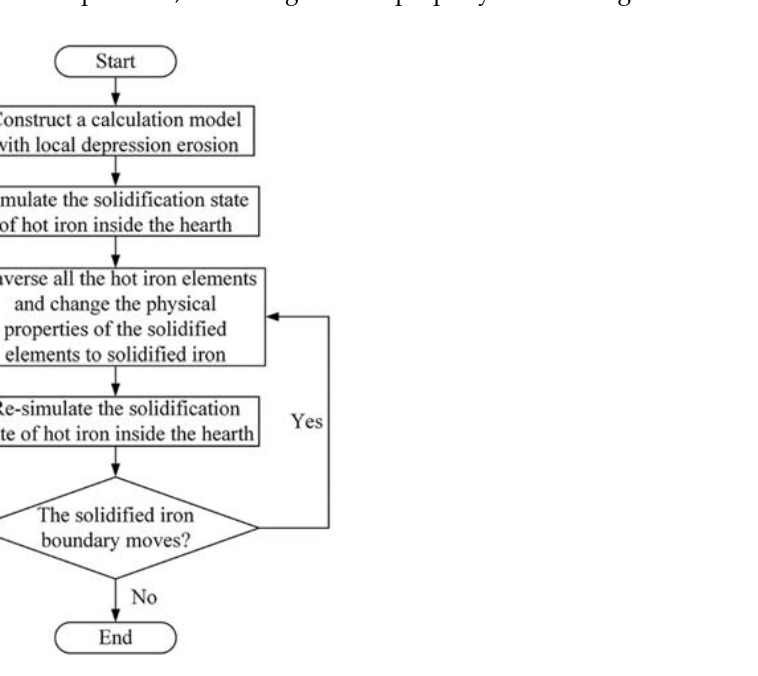
Figure 1. The calculation process of the solidified iron layer.